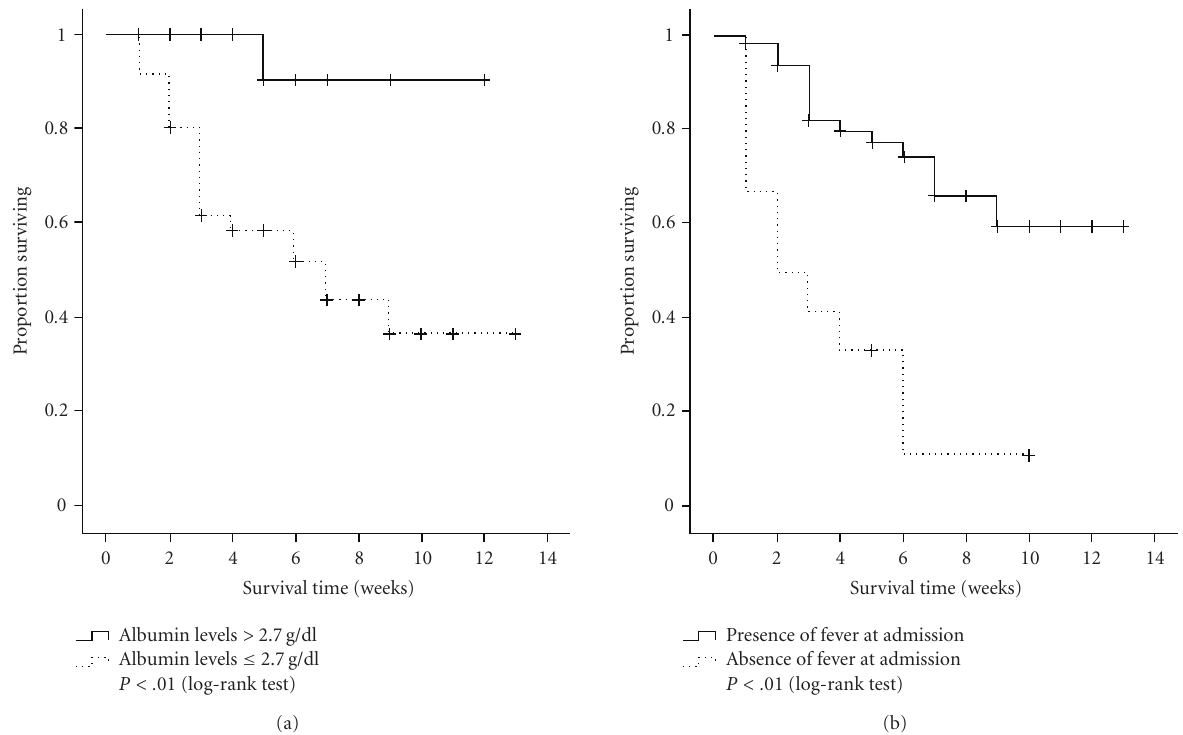
Figure 1: The Kaplan-Meier survival estimates of HIV-infected patients with disseminated TB (a) in relation to basal albumin levels and (b) presence of fever at admission.